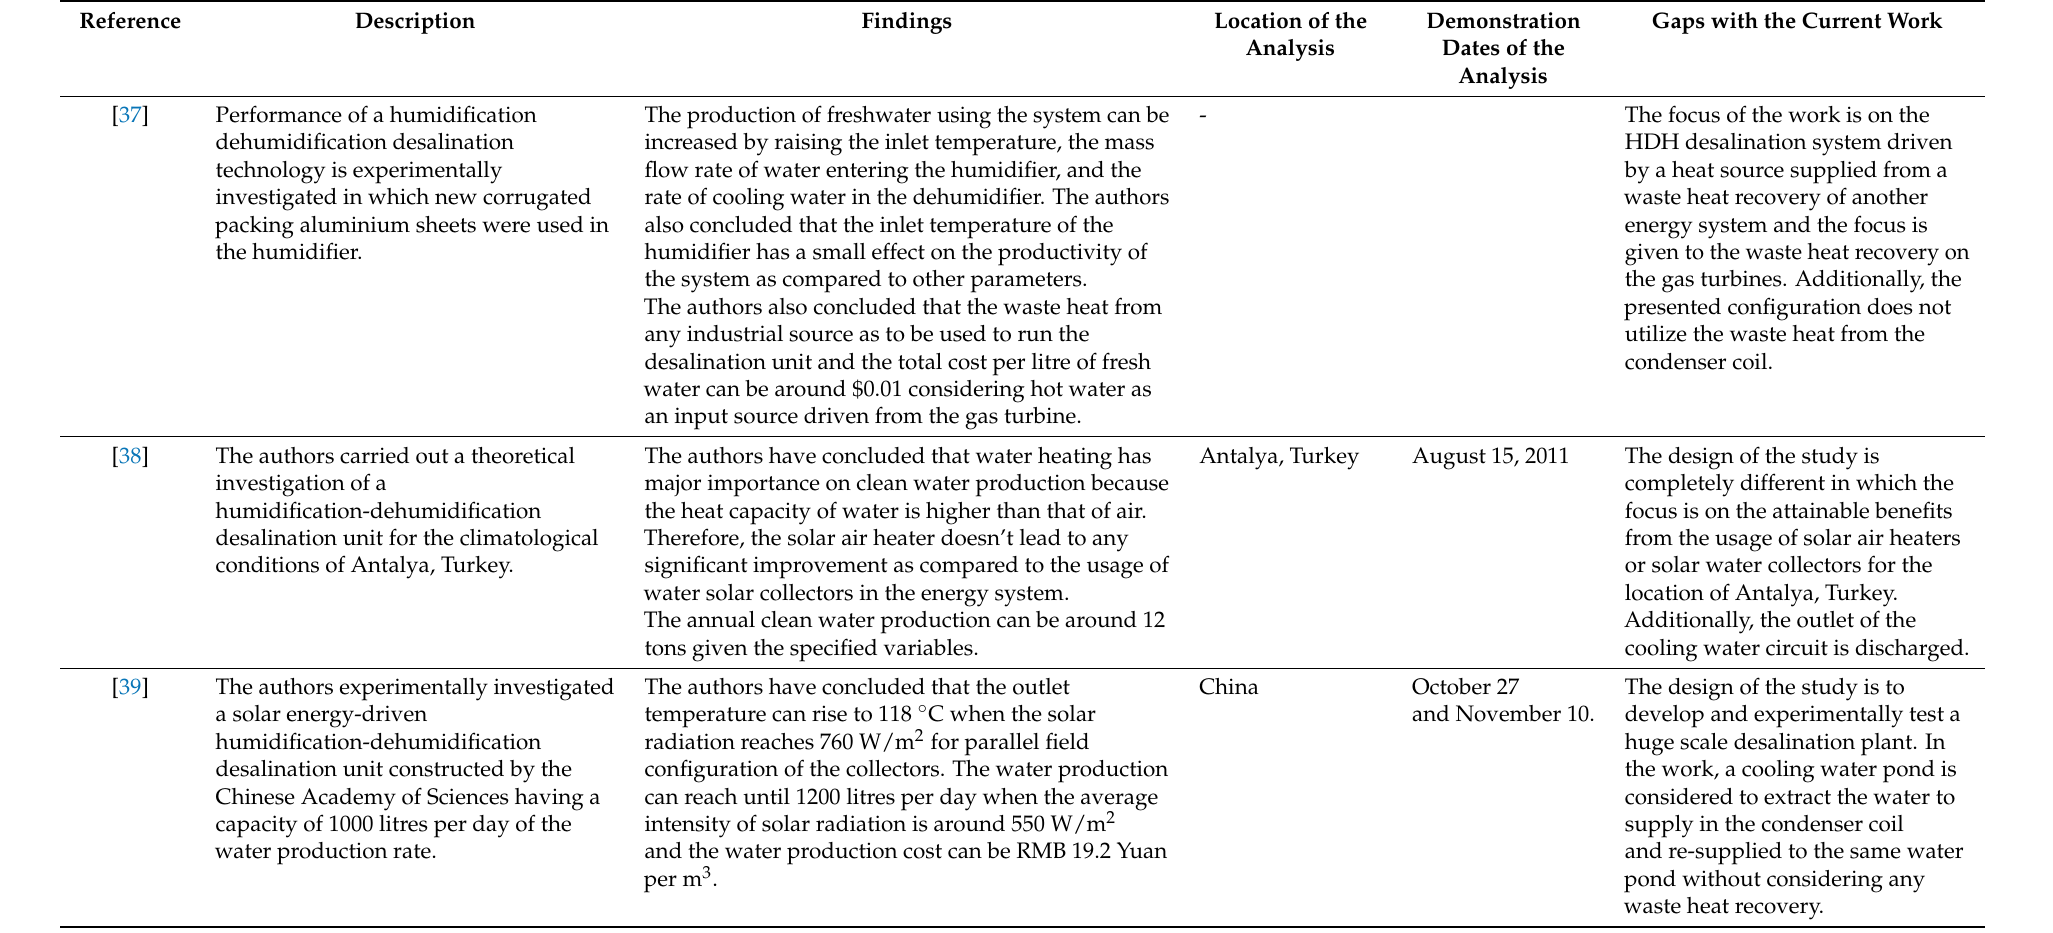
Table 1. Summary of different available waste heat recovery options in desalination systems and their gaps with the proposed scope of